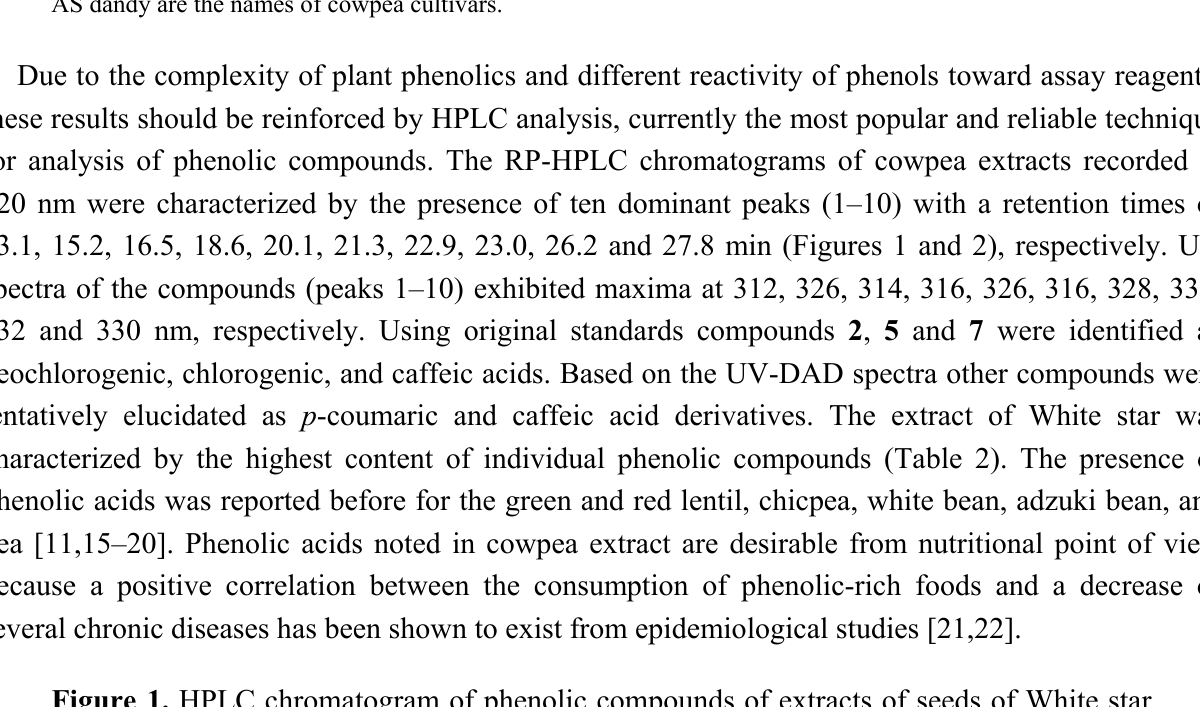
Figure 1. HPLC chromatogram of phenolic compounds of extracts of seeds of White star cowpea cultivar recorded at 320